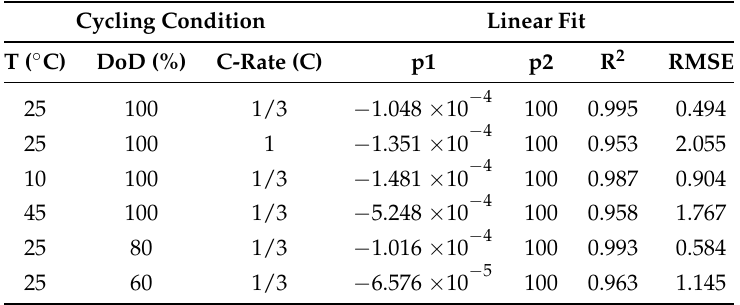
Table 5. Linear fitting results per cycling condition relating total discharge capacity to state of health. Cycling